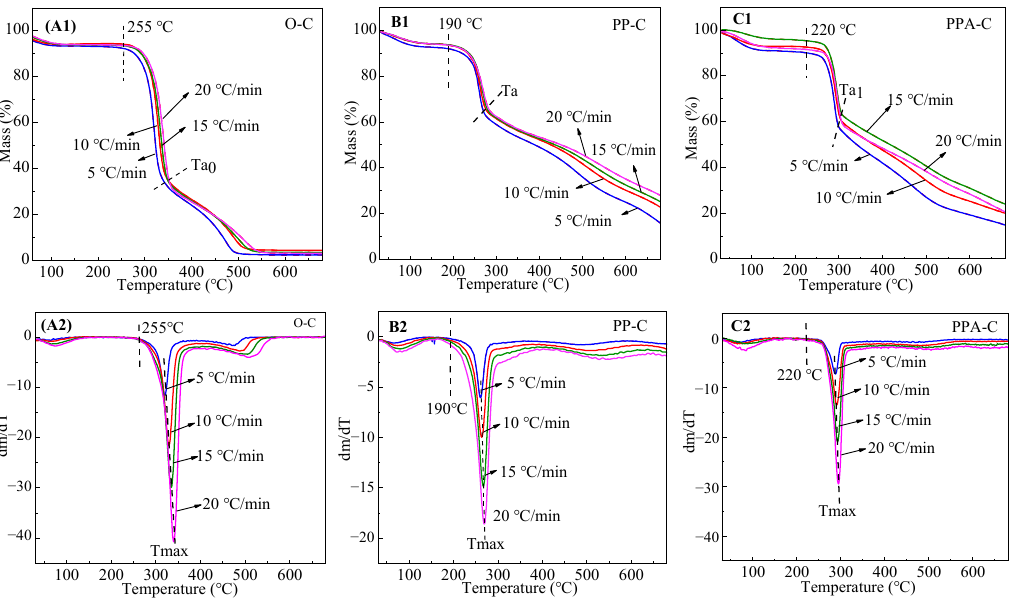
Figure 7. TG–DTG of cotton fabrics at different heating rates (air atmosphere). ( A1 – C1 ) were the TG of the O-C, PP-C, PPA-C fabrics respectively and ( A2 – C2 ) were the DTG of the O-C, PP-C, PPA-C fabrics respectively .